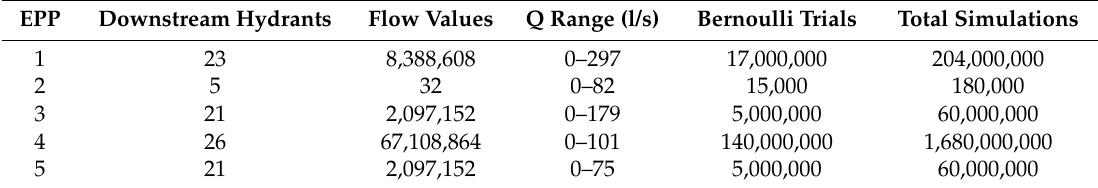
Table 2. Summary of the EPPs found, downstream hydrants, number of possible flow values, flow range and monthly and yearly number of Bernoulli Trials run